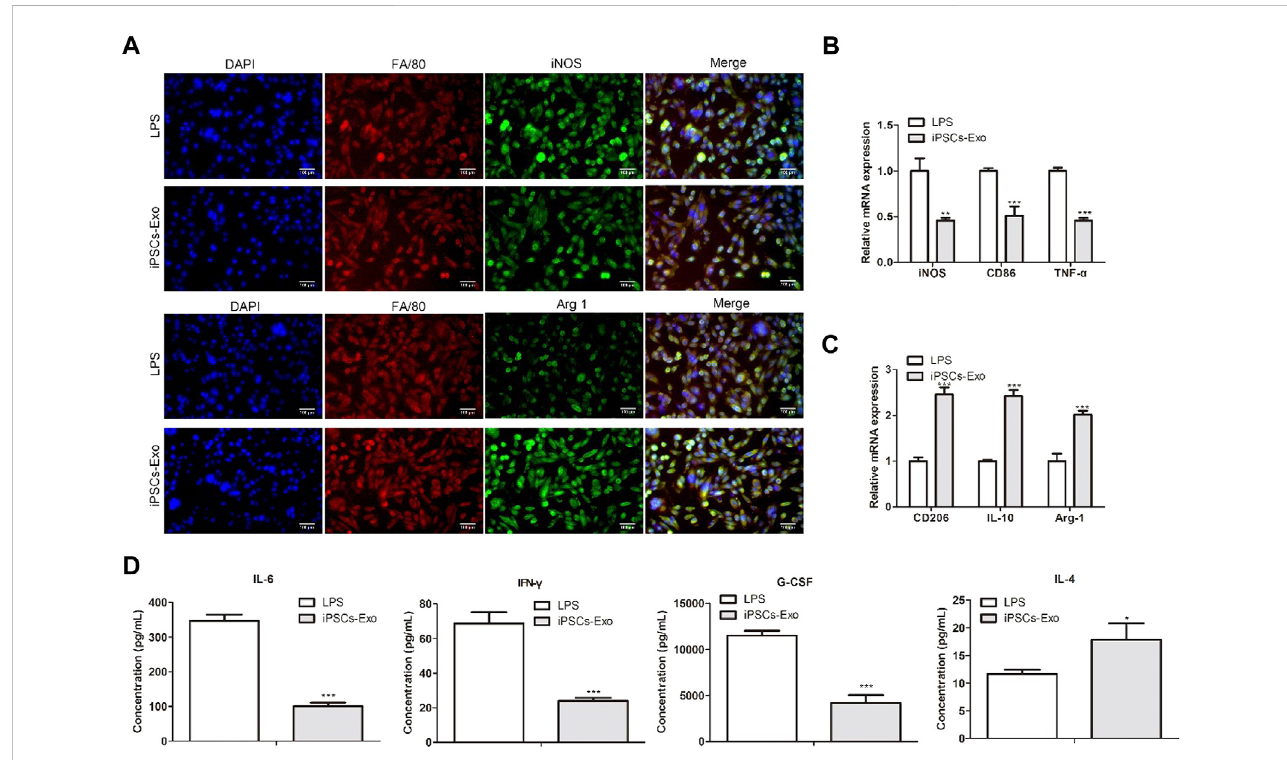
FIGURE 3 IPSCs-Exo polarized macrophages into M2 phenotype in vitro . (A) Immuno fl uorescence showed the expression of iNOS (M1 marker) and Agr1 (M2marker). (B) RT-qPCRshowedM1markerexpression(iNOS,CD86andTNF- α ). (C) RT-qPCRrevealedM2markersexpression (CD206,IL-10andArg1). (D) ELISA detected the concentration of in fl ammatory factors (IL-4, IL-6, IFN- γ , and G-CSF). * p < .05, ** p < .01, and *** p < .001 vs. the control group.